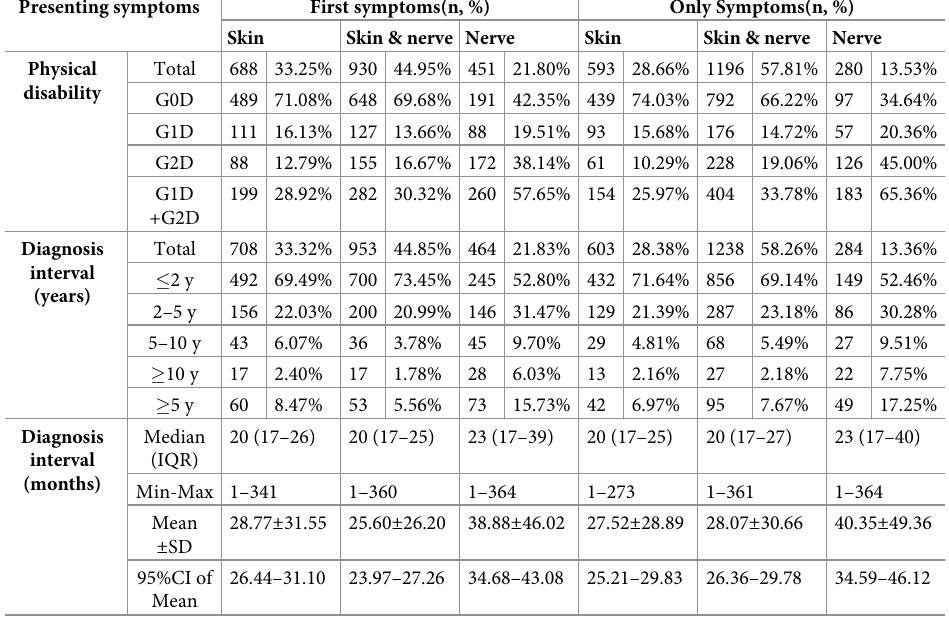
Table 6. Initial Symptoms at Symptom Onset and Only Symptoms at Diagnosis in Newly Detected Leprosy Cases in Yunnan, China, 2010–2020. Presenting